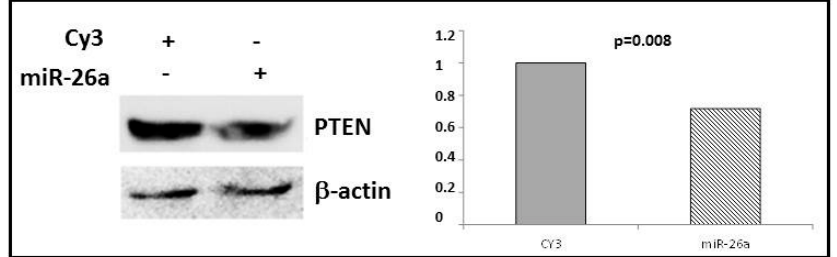
Figure 5. PTEN protein expression was measured by Western blot after transfection with miR-26a or CY3 in MDA-MB-231 cell line. β -Actin was used as a control.